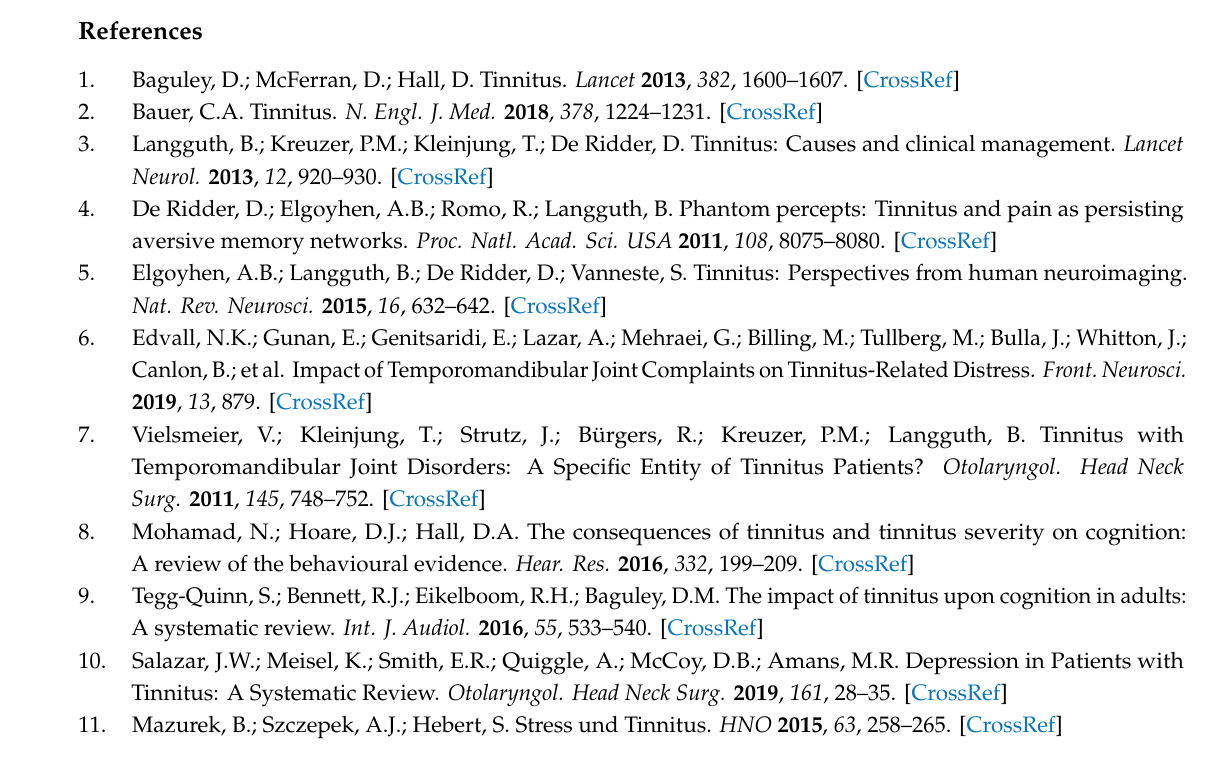
Table S1. Spearman correlation of the THI change with the Items of the social isolation questionnaire; Table S2. Spearman correlation of the mini-TQ change with the Items of the social isolation questionnaire; Figure S1. Scatterplot of the THI change with the Big Five Personality Factors; Figure S2. Scatterplot of the mini-TQ change with the Big Five Personality